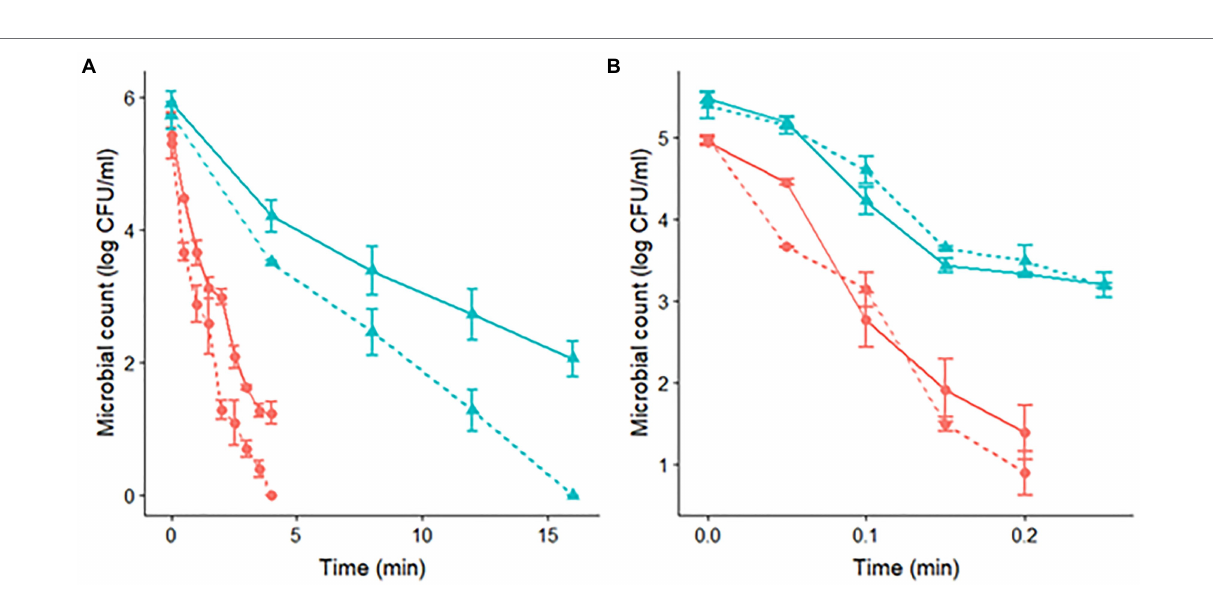
FIGURE 2 | Survivor curves of S. Senftenberg (A) and S. Enteritidis (B) during isothermal treatments at 60 ° C in peptone water and recovered in TSAYE (continuous lines) and TSAYE with NaCl (dashed lines) for experiments performed at pH 7.0 ( ) and pH 4.5 (